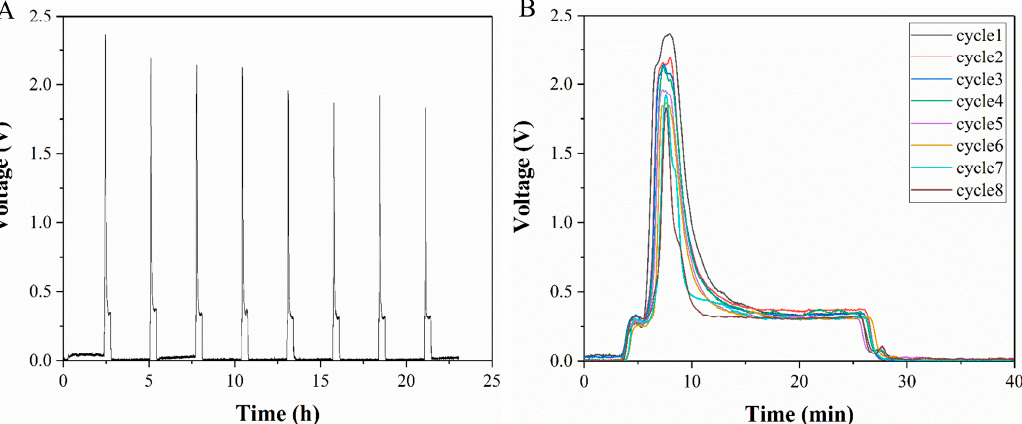
Figure 5. ( A ) Data of cell-generated lactate detected by flow/stop cycles. ( B ) Comparison of detection results in the flow segment of each cycle. Inset: the difference between the detection signal peaks of di ff erent cycles.